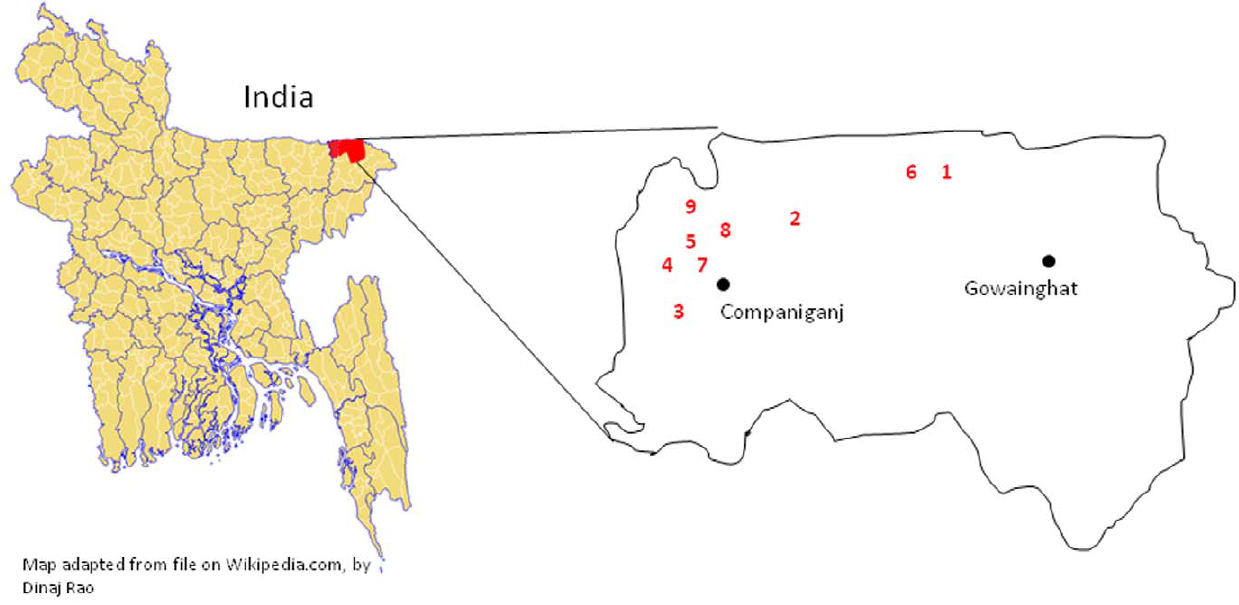
Figure 1. Approximate location of outbreak villages numbered to indicate order in which each village became affected by the outbreak.